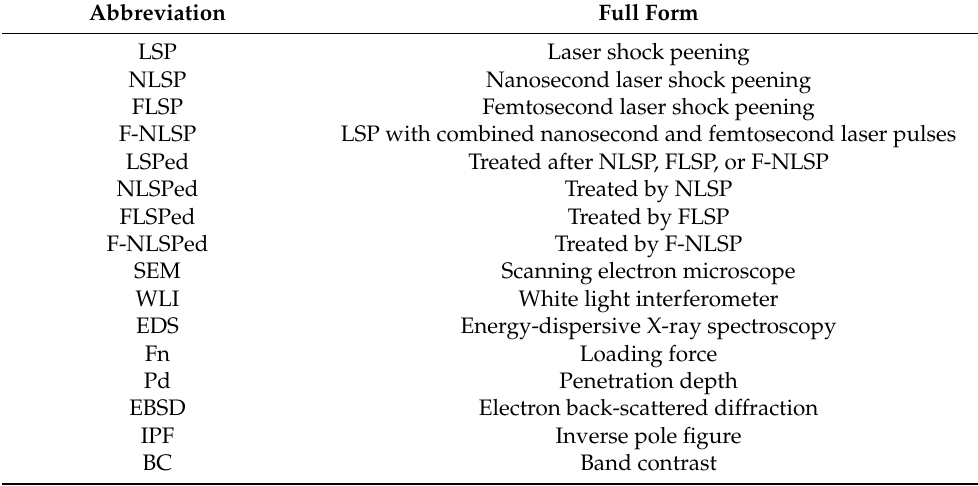
Table 1. List of abbreviations used in this